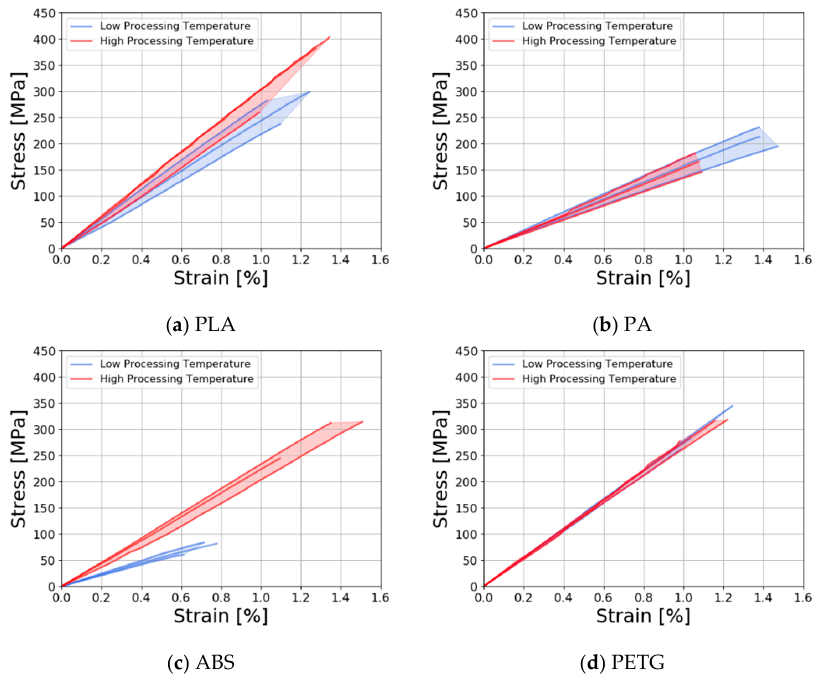
Figure 13. Stress-strain curves of ADFRCs at low processing temperature and high processing temperature with ( a ) PLA; ( b ) PA; ( c ) ABS; ( d ) PETG